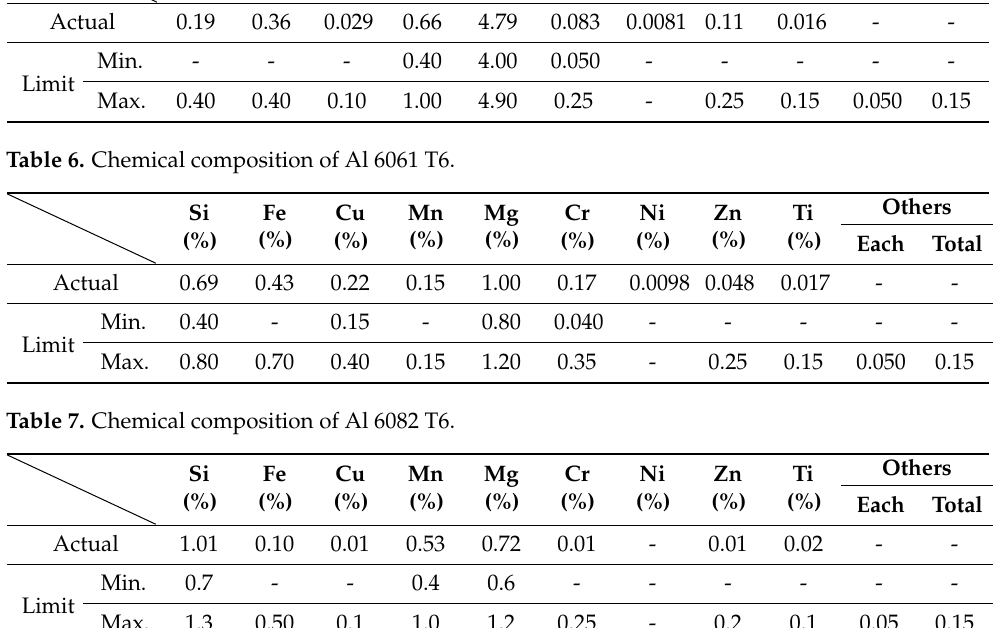
Table 5. Chemical composition of Al 5083 H321.